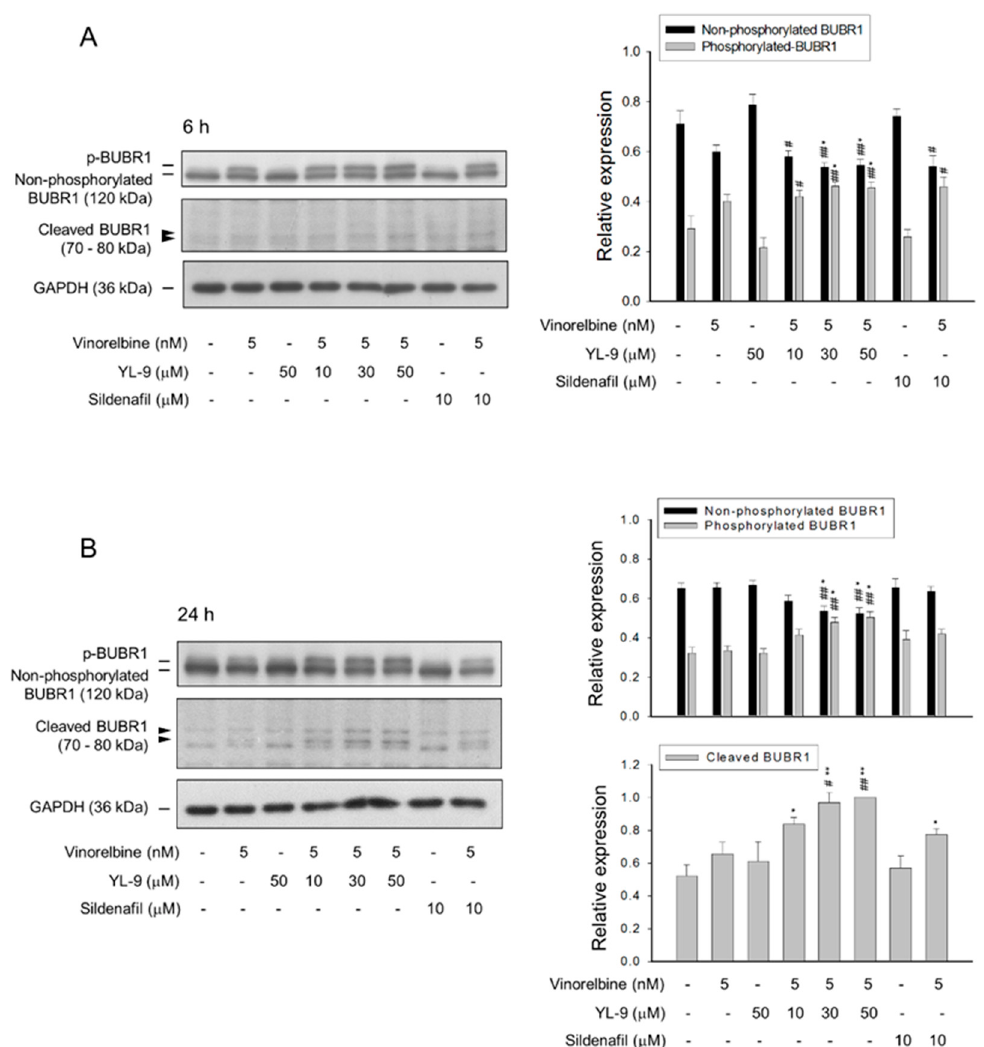
Figure 4. Effect of YL-9 on vinorelbine-induced phosphorylation and cleavage of BUBR1. NCI-H460 cells were incubated with the indicated agents for 6 ( A ) or 24 h ( B ). After the treatment, the cells were harvested for the detection of protein expression using Western blotting analysis. The protein expressions of total BUBR1, including non-phosphorylated and phosphorylated BUBR1 were quantified using Bio-Rad Image Lab TM Software. The expressions of total BUBR1 in each treatment group are summed up as 1.0 of the relative expression ( y -axis). The quantitative data of expressions in cleaved BUBR1, which account for minor portion of BUBR1 expressions, at a 24-h treatment are shown separately and the expression is relative to the group of 5 nM vinorelbine/50 μ M YL-9. Data are expressed as mean ± SEM of three independent experiments. * p < 0.05 and ** p < 0.01 compared with the control. # p < 0.05 and ## p < 0.01 compared with vinorelbine alone.